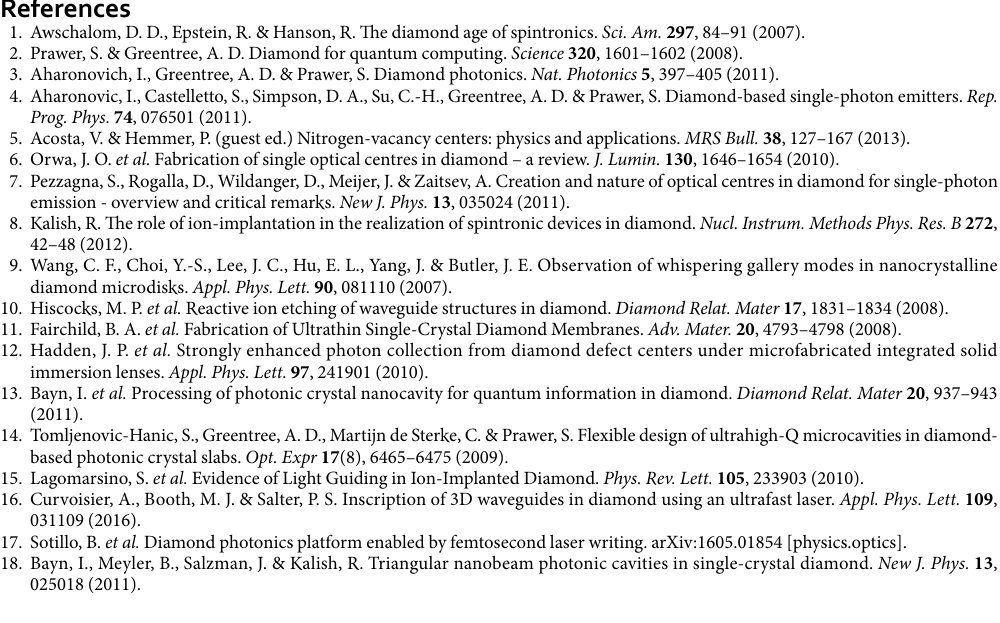
7 Scientific RepoRts | 7: 385 | DOI:10.1038/s41598-017-00343-0